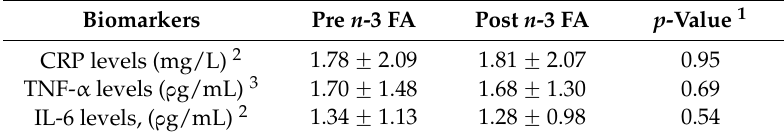
Table 2. Pre- and post-supplementation inflammatory marker levels ( n = 191). Biomarkers